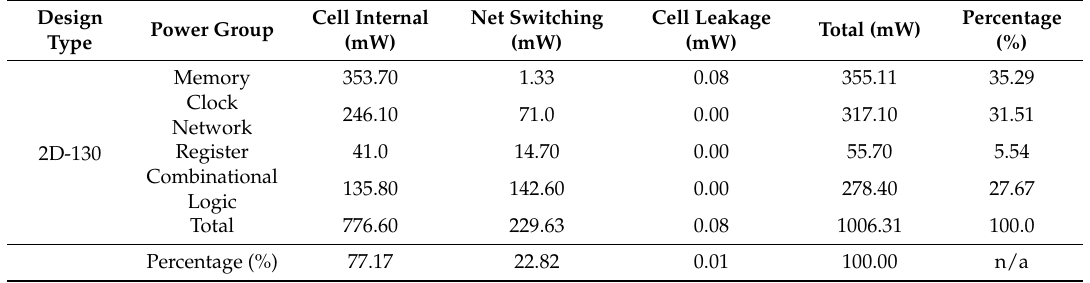
Table 9. Detailed power comparisons of 2D and 3D ICs designed in 45-nm technology. Design Type